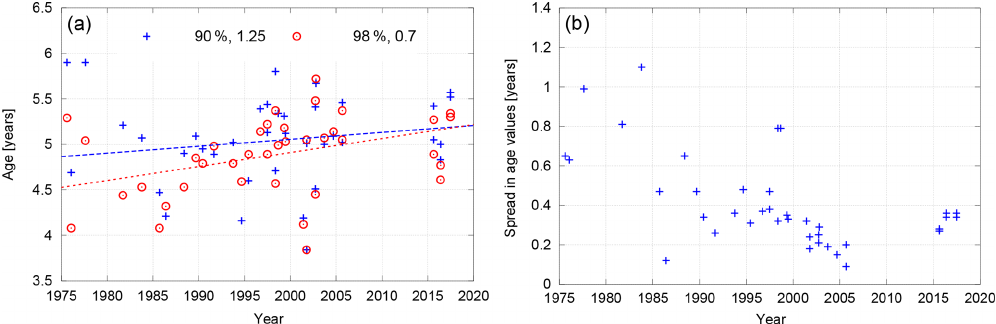
Figure 18. (a) Example AoA time series derived from the observations using F = 90%, a 1.25-year ratio of moments and F = 98%, 0.7 years. (b) The difference between maximum and minimum mean AoA found from the observations for the considered parameters (0.7, 0.8, 1.0 and 1.25 years for fit and convolution method and 90%, 95% and 98% for the fit